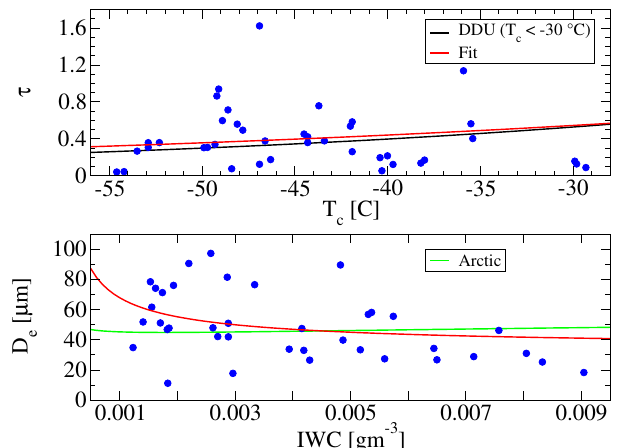
Figure 12. Retrieved data (blue) and fit (red) of optical depth as a function of temperature compared with the Dumont D’Urville (DDU) statistics (black) in the upper panel and with the Arctic D e − IWC distribution (Liou et al., 2008) (green) in the lower panel. where a = 4 . 8510, b = 0 . 33159 and c = 0 . 026189 are